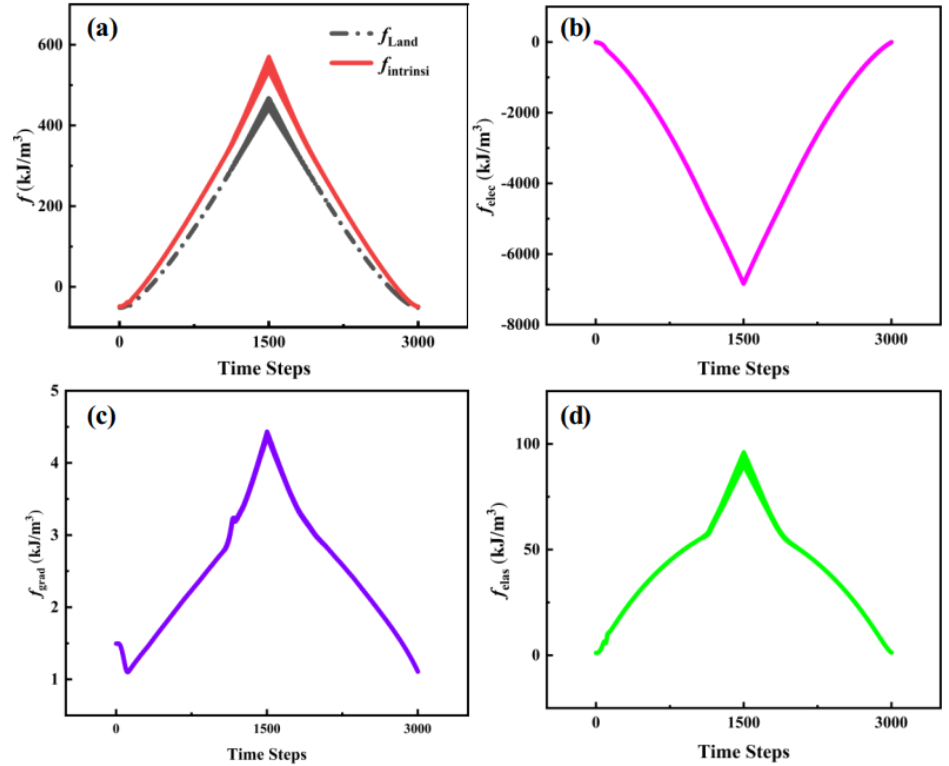
Figure 4. The volumetric average intrinsic energy density (consisting of Landau, gradient, and elastic energy density) and the average electrostatic energy density under different electrical conditions in K 0.5 Na 0.5 NbO 3 thin films. The time steps of 0–1500 represent the loading process, while the 1500–3000 represent the unloading process. ( a ) Landau and intrinsic energy density. ( b ) Electrostatic energy density. ( c ) Gradient energy density. ( d ) Elastic energy density.